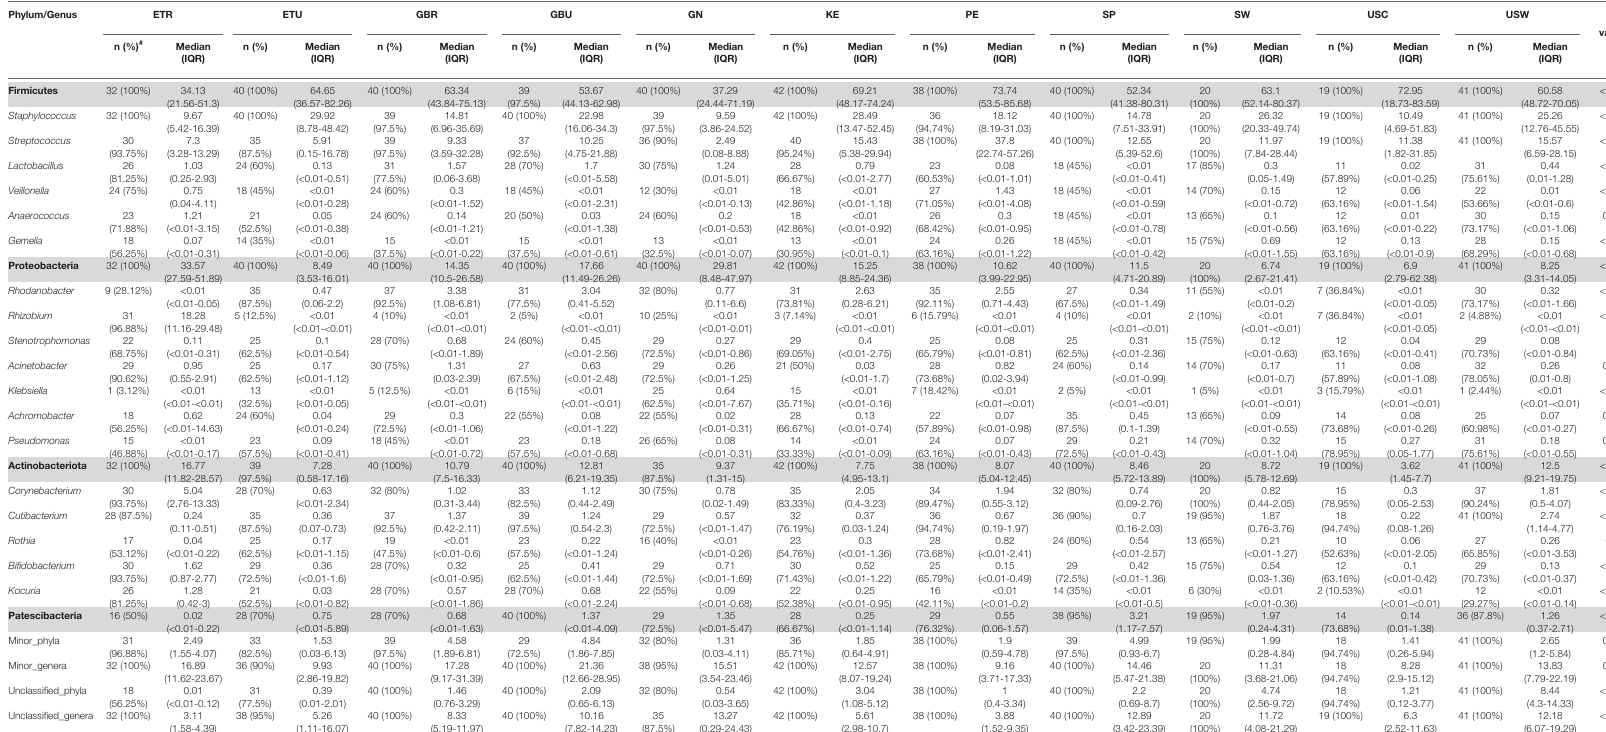
TABLE 1 | Relative frequencies, medians and interquartile range (IQR) of the most abundant bacterial phyla (bold) and genera detected in the milk samples analyzed in this